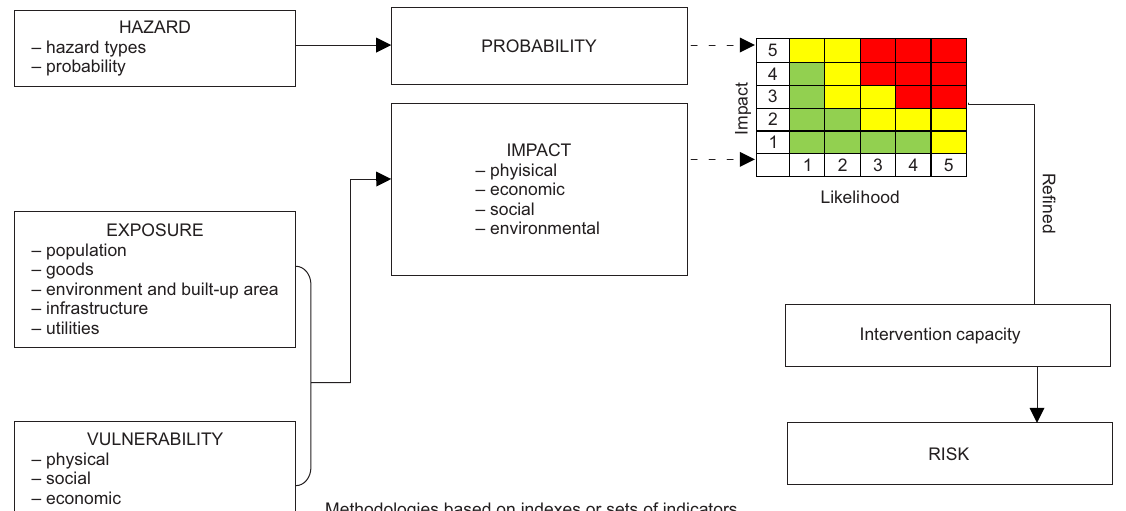
Fig. 3. Assessment model of social